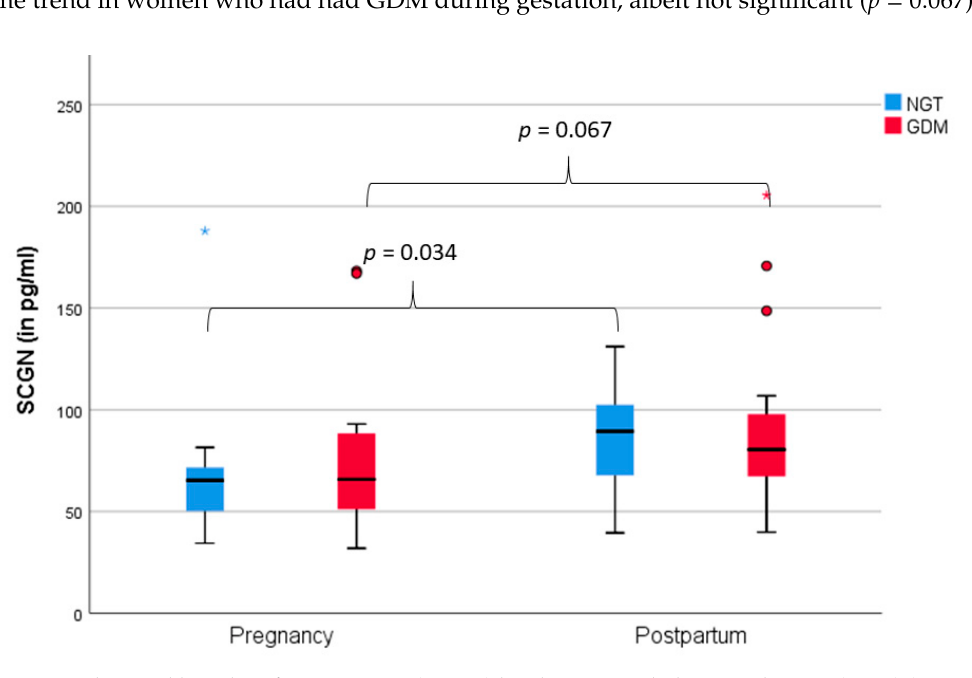
Figure 1. Clustered boxplot of secretagogin (SCGN) levels in normal glucose tolerance (NGT) ( n = 19) and gestational diabetes mellitus (GDM) ( n = 15) during pregnancy and postpartum